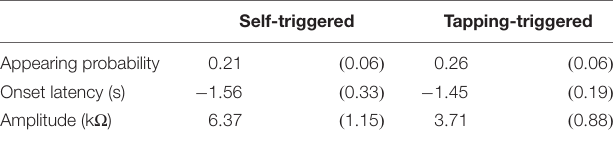
TABLE 11 | EDR induced by self-triggered translation and tapping-triggered